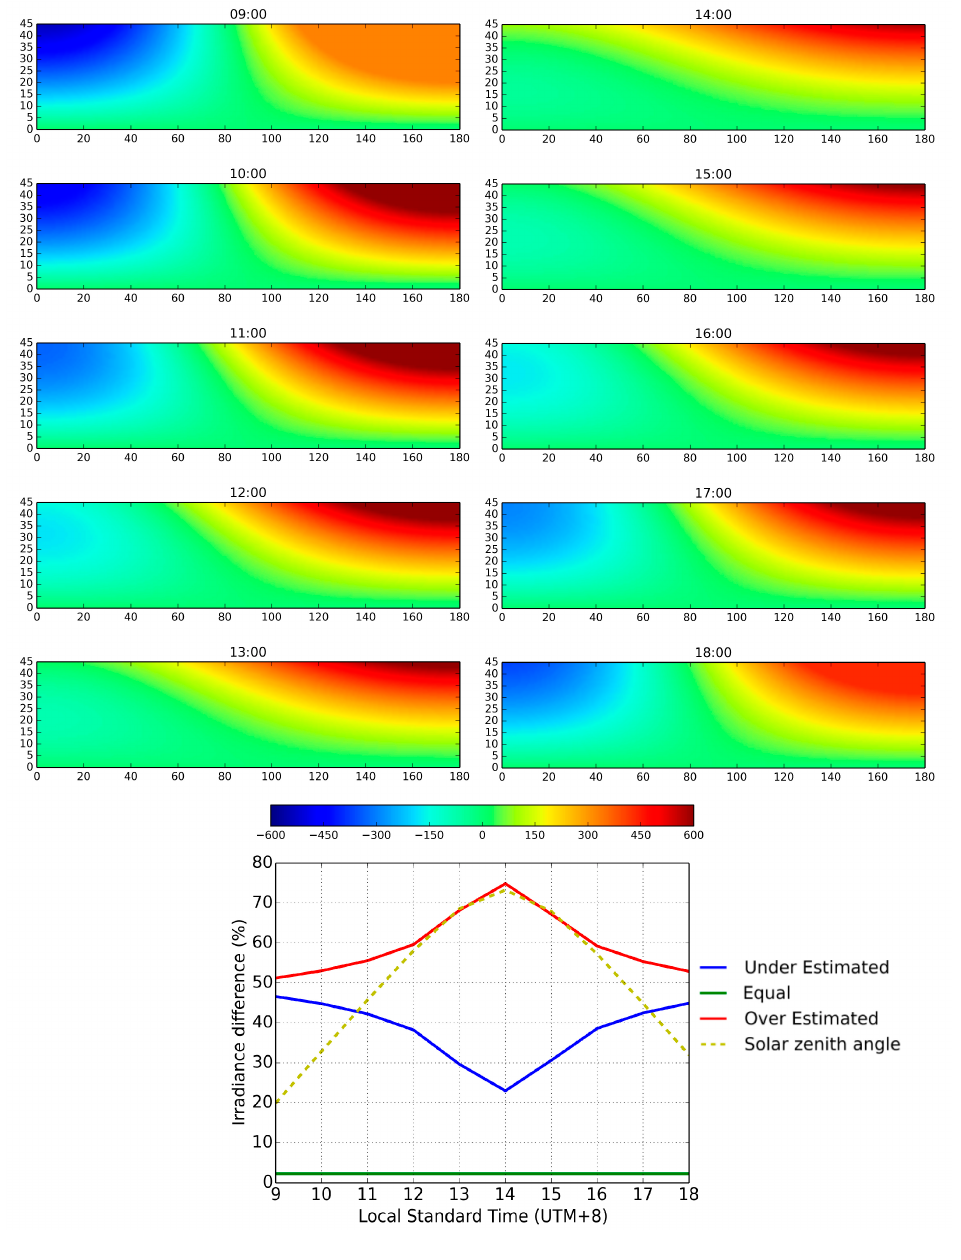
Figure 10. Difference between irradiance ( W·m − 2 ) computed without and with sub-pixel topographic correction over the day (DOY = 115): ( top ) Difference maps ranging from − 600 (blue) to 600 (red) with the X axis representing the slope gradient and the Y axis the relative aspect, both in degree. ( bottom ) Irradiance difference summary according to local standard